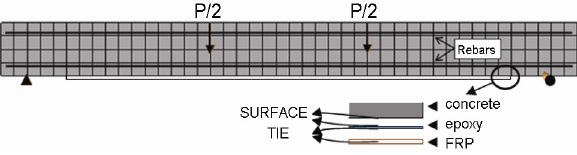
Fig. 9. Typical finite element